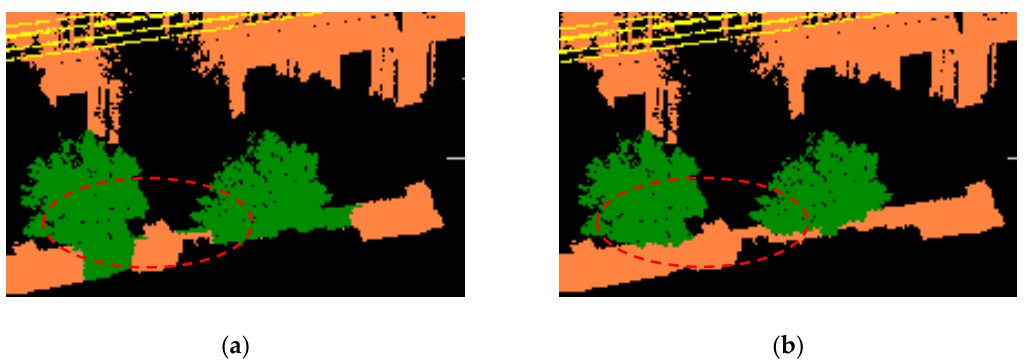
Figure 8. Classification results after optimization. ( a ) results after ordinary K-nearest neighbor optimization; ( b ) results after optimized K-nearest neighborhood optimization.